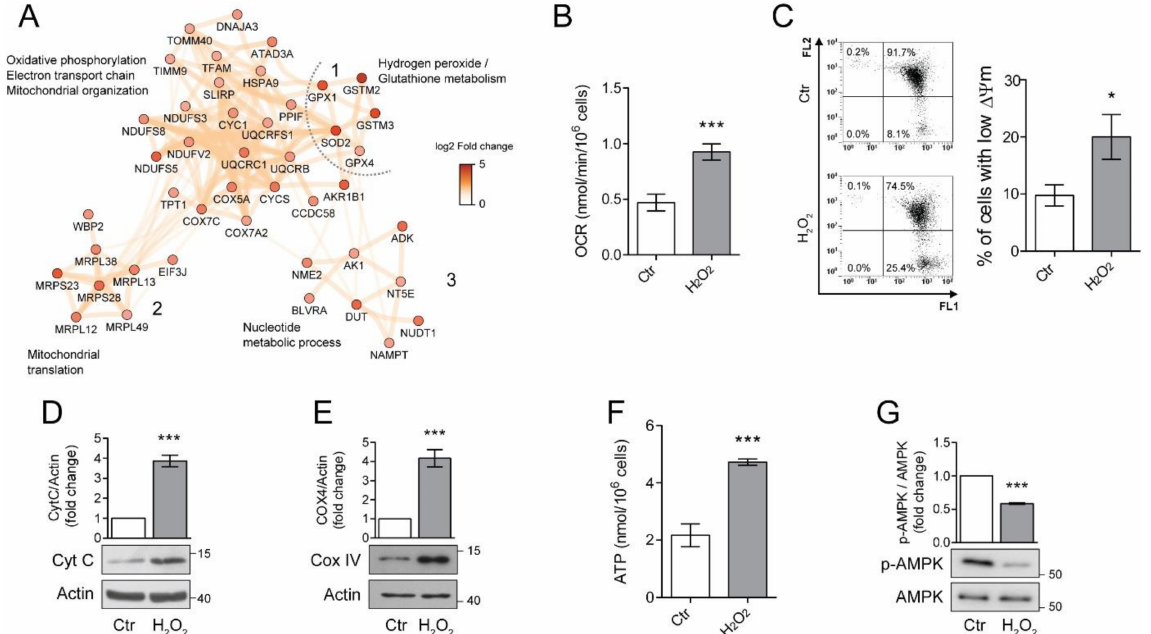
Figure 3. Chronic sublethal oxidative insult induces mitochondrial alterations in ARPE-19 cells. ( A ) Network of up-regulated protein clusters involved in mitochondrial and energy-related processes. Cluster 1 was linked to oxidative phosphorylation, electron transport and mitochondrial organization, cluster 2 included several proteins involved in mitochondrial translation, while cluster 3 was composed of proteins involved in nucleotide metabolism. Color is related to the log2-fold change difference in expression between H 2 O 2 and Ctr. Ctr and H 2 O 2 treated cells were seeded in H 2 O 2 -free medium, grown for 72 h and used for the experiments; ( B ) Oxygen concentration was recorder in 1 mL of respiration buffer containing 200 nmol oxygen/mL at 37 ◦ C. Data are expressed as nmol/min/10 6 cells and are the mean ± SD of four independent experiments; ( C ) Cells loaded with 1.5 µ M JC-1 for 30 min and analysed by flow cytometry. Representative dots (upper panel) represent a single cell analysed for its green (FL1) and orange (FL2) associated fluorescence. Number in each quarter indicate the cell population percent. In the histogram, data represent the mean ± SD of three independent experiments; ( D , E ) Western blotting analysis of Cytochrome C (Cyt C) and Cytochrome oxidase IV (COXIV), respectively. β -actin was used as loading control. Bar graphs represent the densitometric analysis reported as the ratio between protein and β -actin band intensity. Untreated cells were used as control and assumed as 1. One representative blot is shown and densitometric analyses are expressed as the mean ± SD of three independent experiments; ( F ) Total cellular ATP levels measured by ATP luminescence-based assay and reported as nmol/10 6 cells; ( G ) Western Blotting of phosphorylated and total AMPK. Bar graphs represent the densitometric analysis reported as the ratio between phosphorylated and unphosphorylated AMPK band intensity. Untreated cells were used as control and assumed as 1. One representative blot is shown and densitometric analyses are expressed as the mean ± SD of three independent experiments (* p < 0.05, *** p <